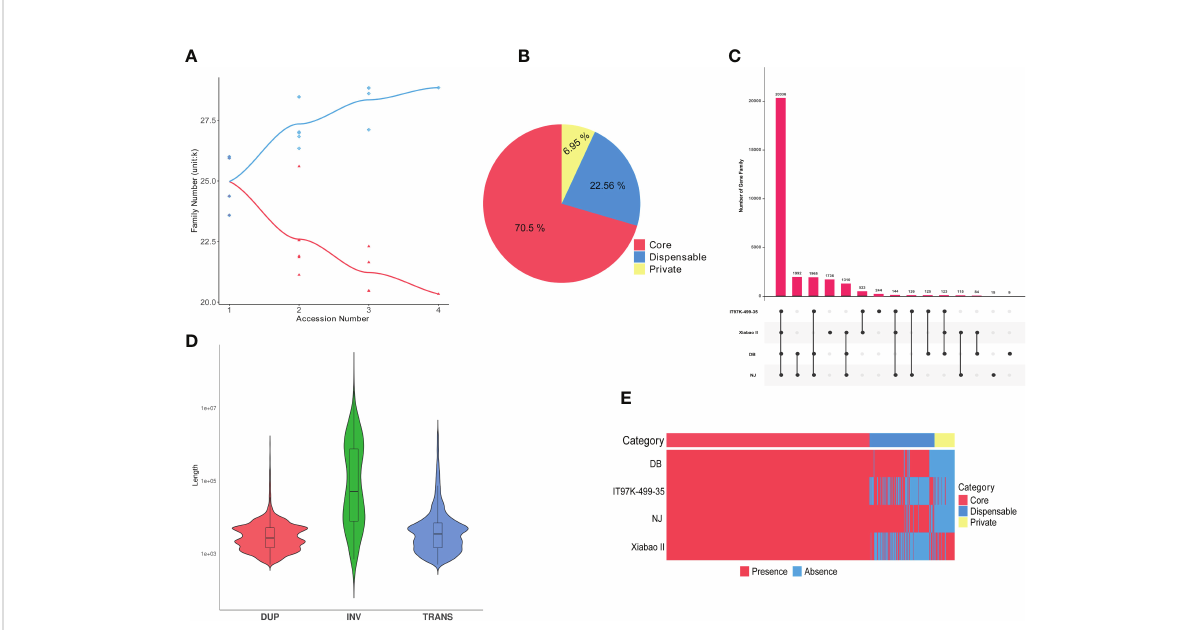
FIGURE 3 Cowpea pan-genome. (A) . Gene family accumulation curves for the pan-genome (blue) and core genome (orange). (B) . Pie charts show the proportion of each core, variable, and unique gene family. (C) . Quantitative dendrograms and dumbbell diagrams of core, variable, and unique gene families in the pan-genome. (D) . Violin plot of length statistics for each type of SV (TRANS: chromosomal translocation; INV: inversion; DUP: duplication). (E) . Presence/absence information of pan gene families in the NJ, DB, =IT97K-499-35 and Xiabao